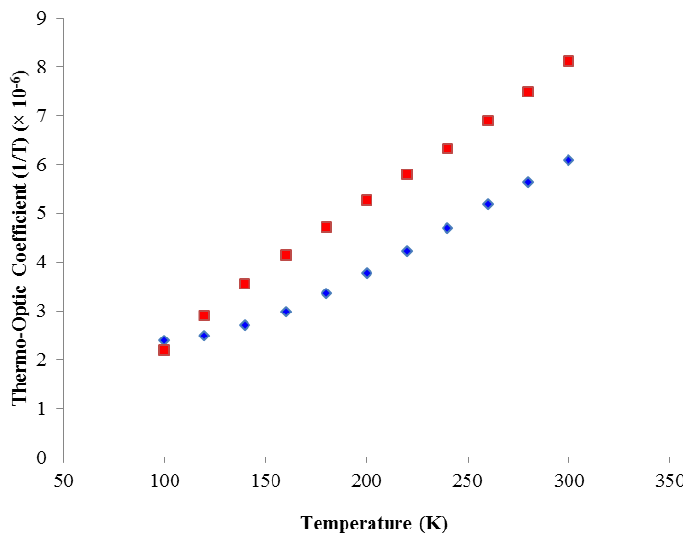
Figure 32. Thermo-optic coefficient as a function of absolute temperature for undoped Y 2 O 3 (blue) [3] and Sc 2 O 3 (red) [30], measured at a wavelength of 1064 nm.